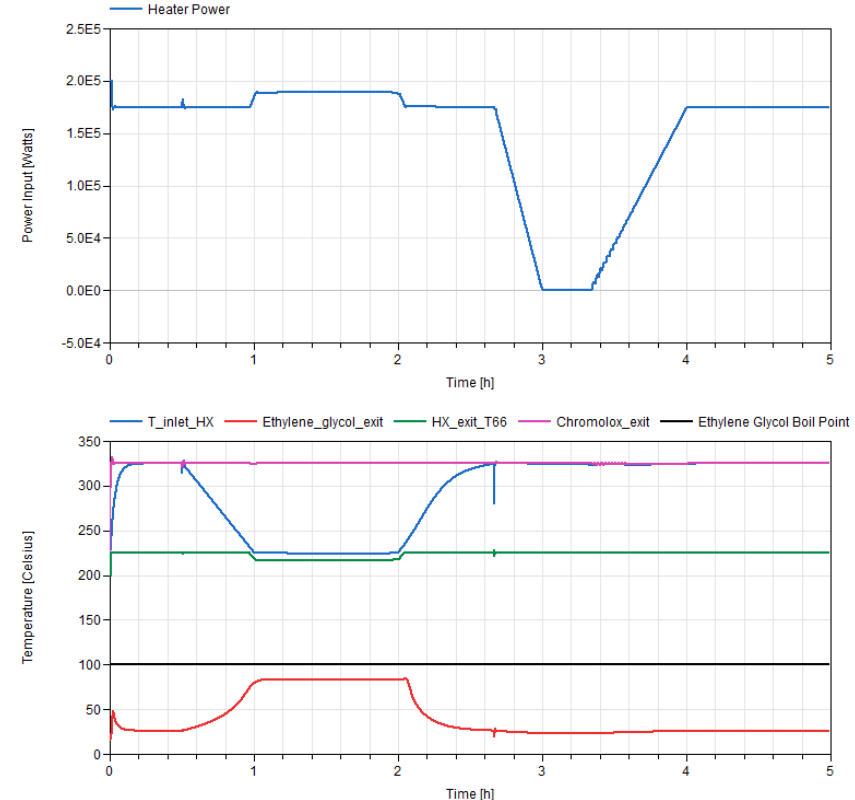
Figure 12. Shakedown Testing: ( Top ) Chromalox heater input. ( Bottom ) Temperatures throughout the TEDS loop.